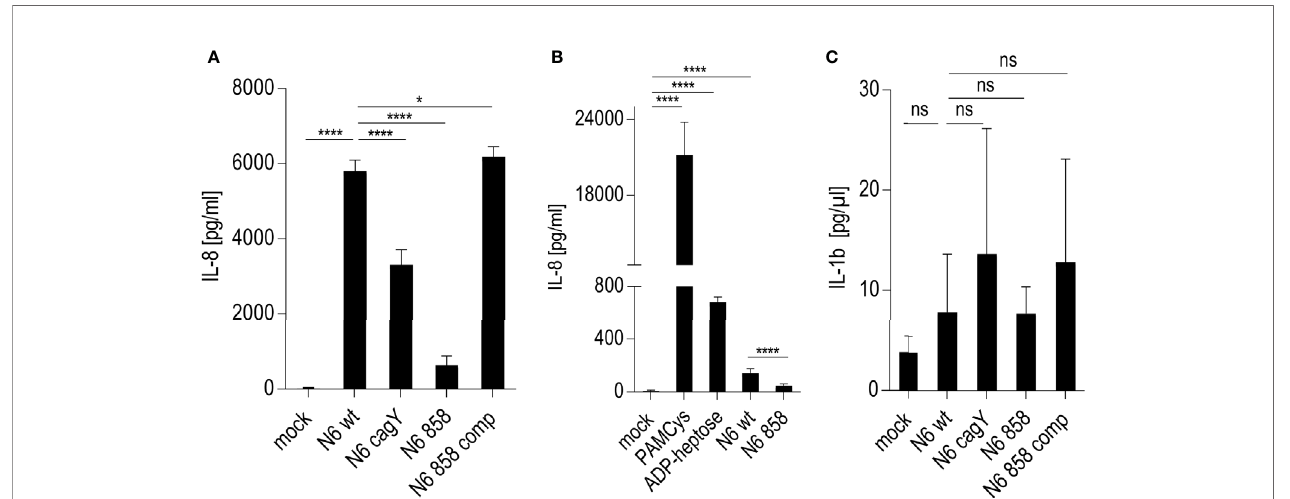
FIGURE 4 | Response of NLRP3-de fi cient Thp-1 monocyte/macrophage cells (Thp-1 dNLRP3) to live H. pylori and pure ADP-heptose. (A, B) show IL-8 secretion by co-incubated, NLRP3-de fi cient Thp-1 cells. (A) Thp-1 NLRP3def cells co-incubated with live H. pylori bacteria of different genotypes at MOI 5 for 20 h in 24 well format (B) Thp-1 dNLRP3 cells co-incubated with H. pylori ETL (50 µl/well) from OD 600 = 2 in 24-well plate for 20 h. As controls, for TLR (3) activation, PAMCys at 400 ng/well, and for ALPK1 activation, ADP-heptose at 5 µM, respectively, were added in parallel experimental conditions. (C) IL-1 b secretion by NLRP3def Thp-1 cells co-incubated with live H. pylori variants as in (A) . Results of one representative experiment out of three independent experiments are shown in each panel. Cell responses in (A – C) were quantitated using cytokine ELISA. Cells were not primed before adding the respective stimuli. IL-8 was not decreased (rather increased) in NLRP3-de fi cient cells upon H. pylori co-incubation, while IL-1 b was signi fi cantly decreased and lost the CagT4SS-and heptose-dependent phenotype upon de fi ciency of NLRP3. Statistical differences were calculated by unpaired student ’ s t -test. Signi fi cant p values: ****p < 0.0001; *p < 0.05; ns is non-signi fi